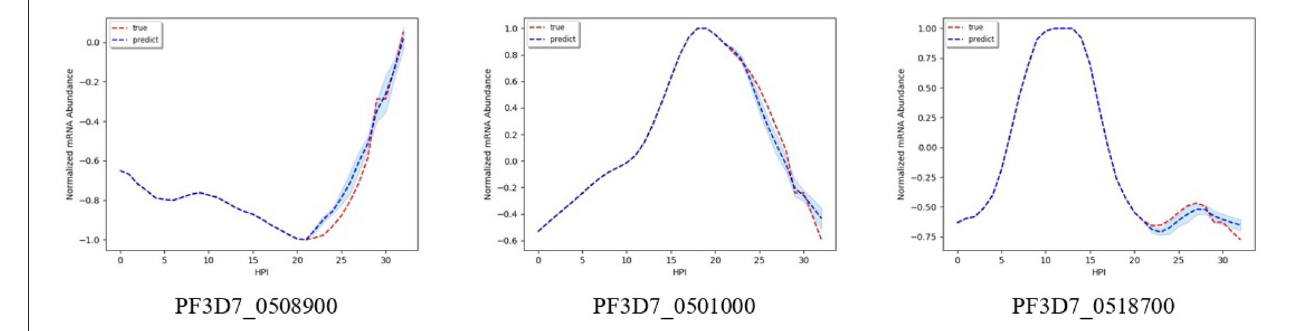
FIGURE 2 | Examples of results for experiment 1.